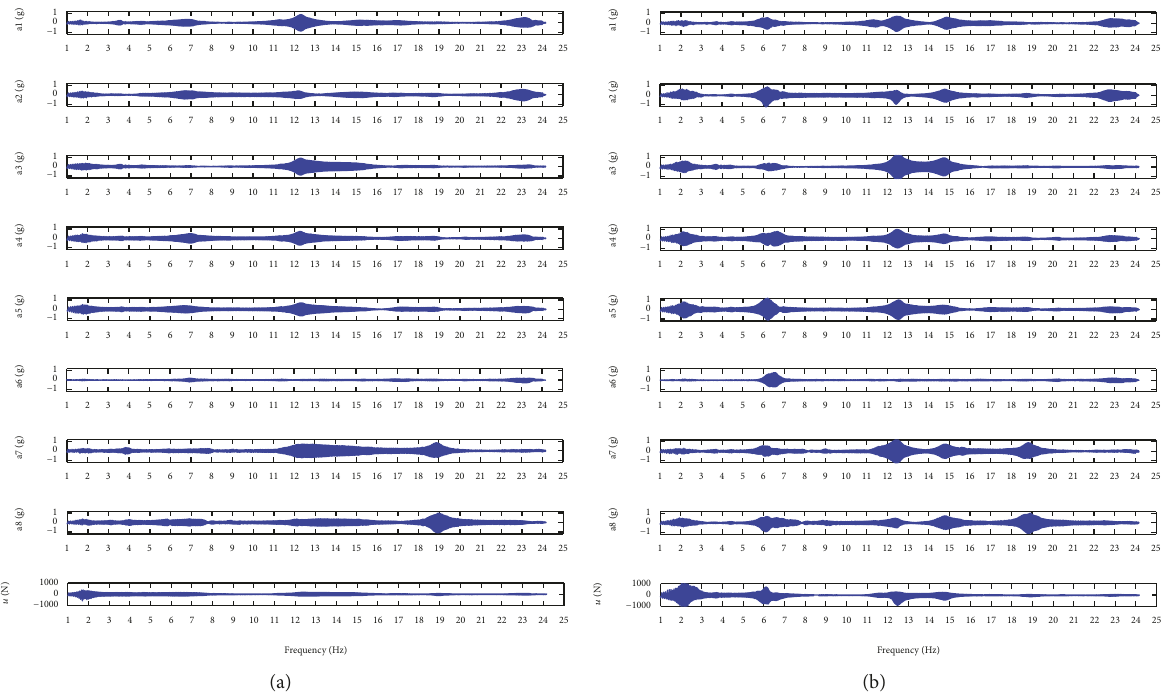
Figure 6: Passive connected (PC) configuration, acceleration measured by sensors a1–a8 and control force, voltage level (a) 0V and (b) 2.5 V. Sine sweep frequency test PGA